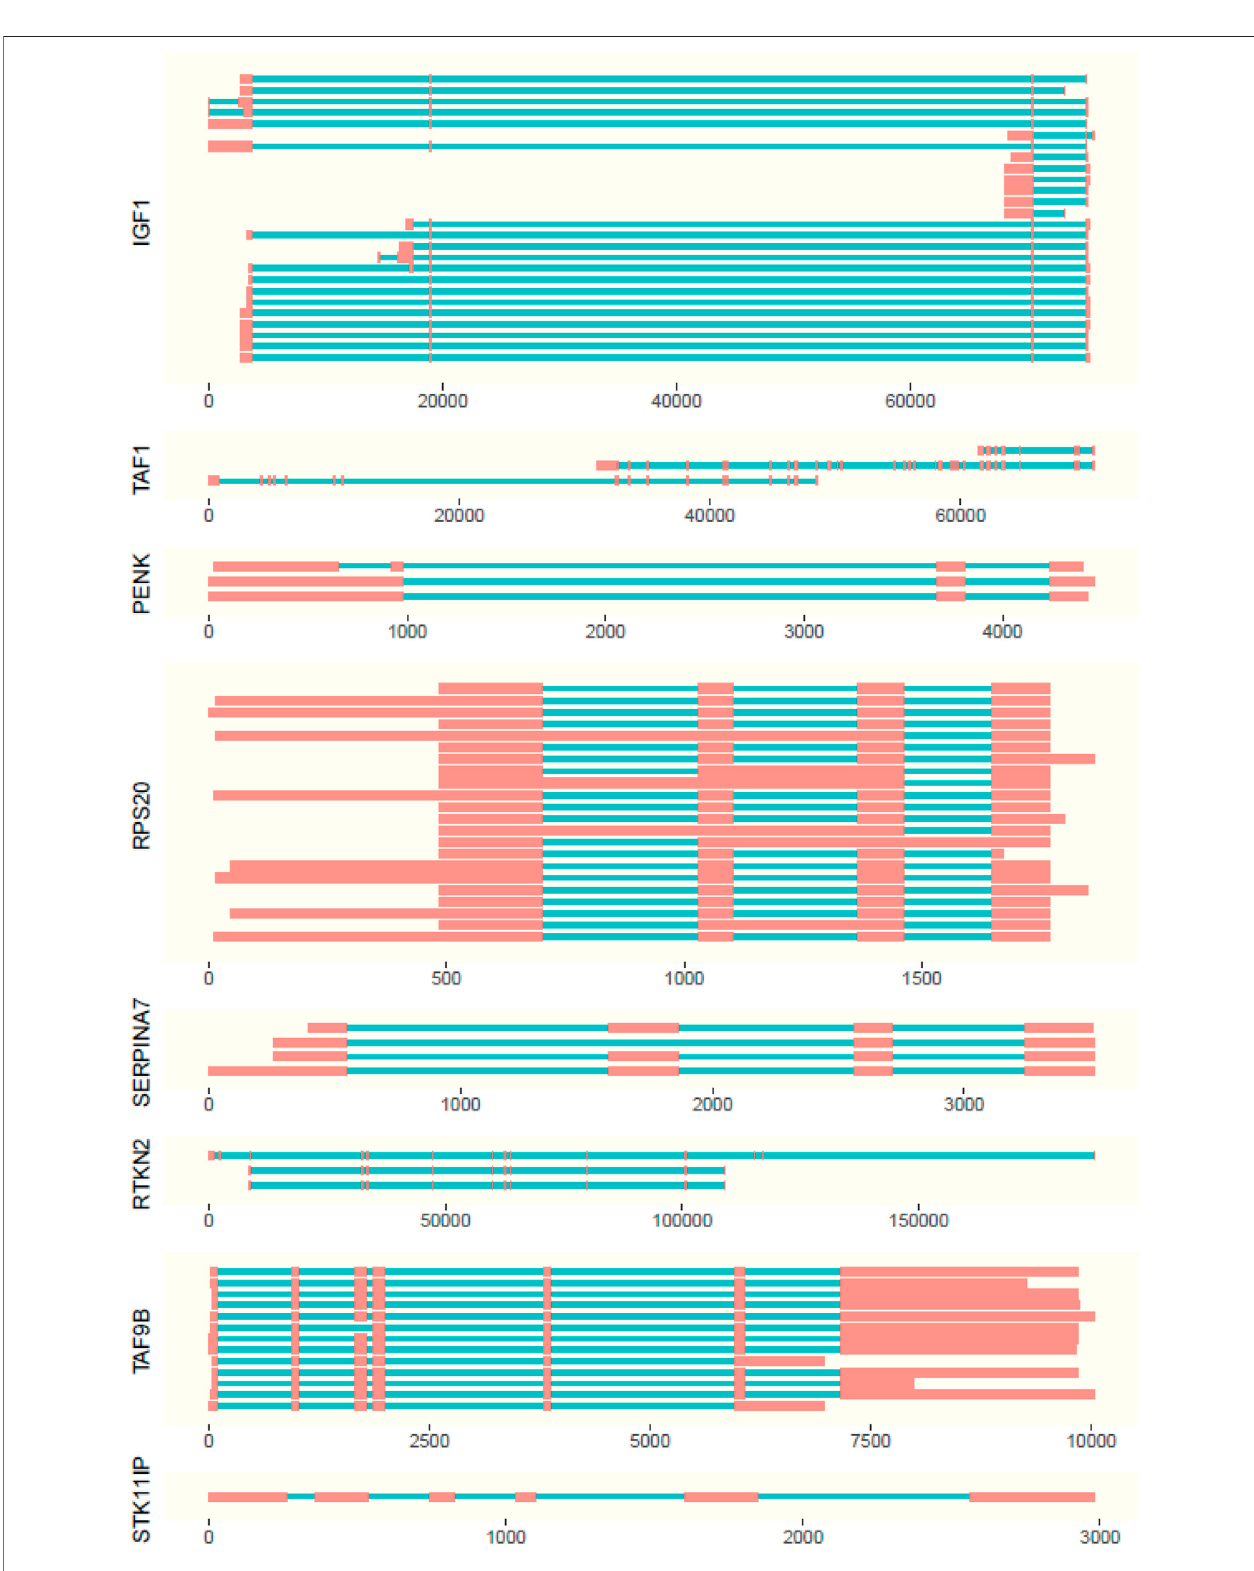
FIGURE 3 | Representation of isoforms with length of exons (red boxes) and introns (blue lines). Positions are displayed relative to the fi rst expressed base pair (x axis) of the gene.